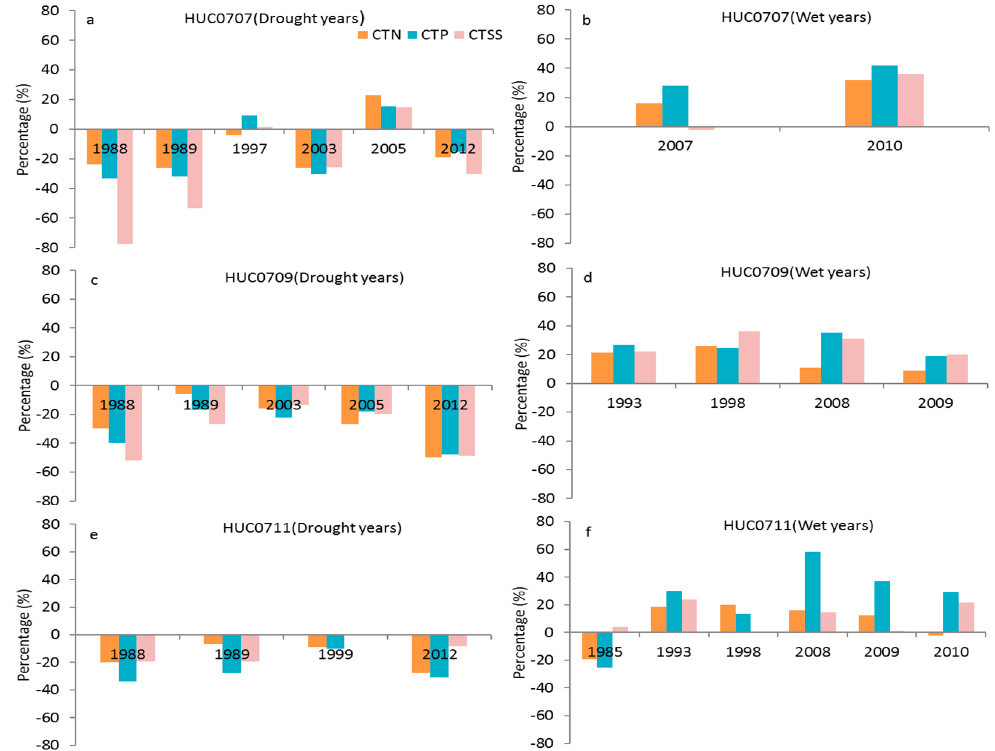
Figure 9. The percentage changes of TN , TP and TSS concentrations (C TN , C TP , C TSS ) in drought years ( a , c , e ) and wet years ( b , d , f ) based on the 30-year mean value for three subbasins (HUC0707, HUC0709, and HUC0711).